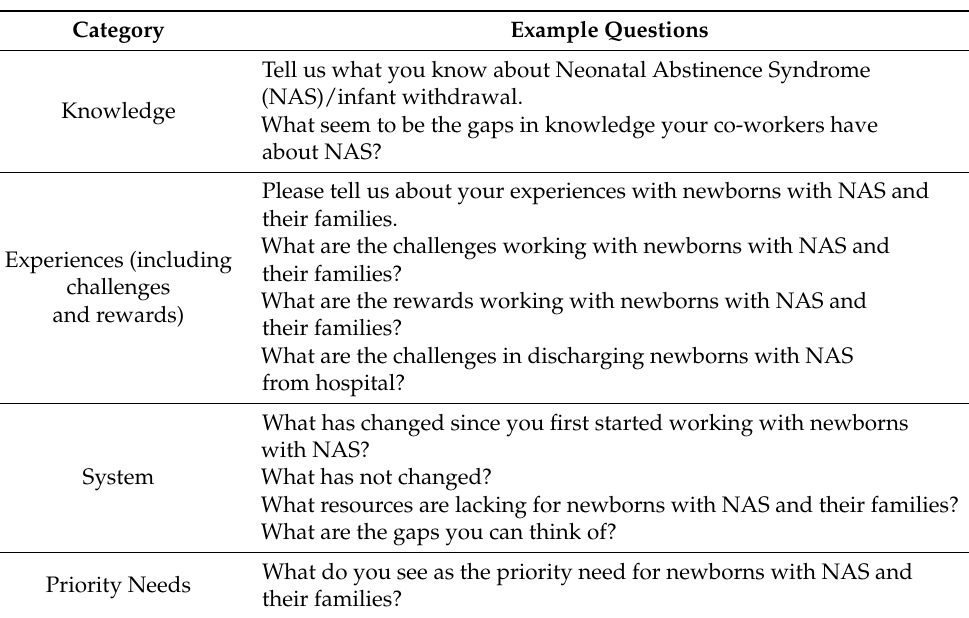
Table 1. Comprehensive Accessible Mother-Infant Dyad Care for Neonatal Abstinence (CAIN) study interview